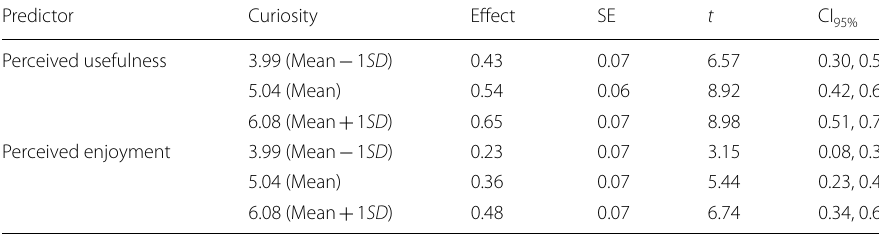
Table 4 Moderation effect of curiosity